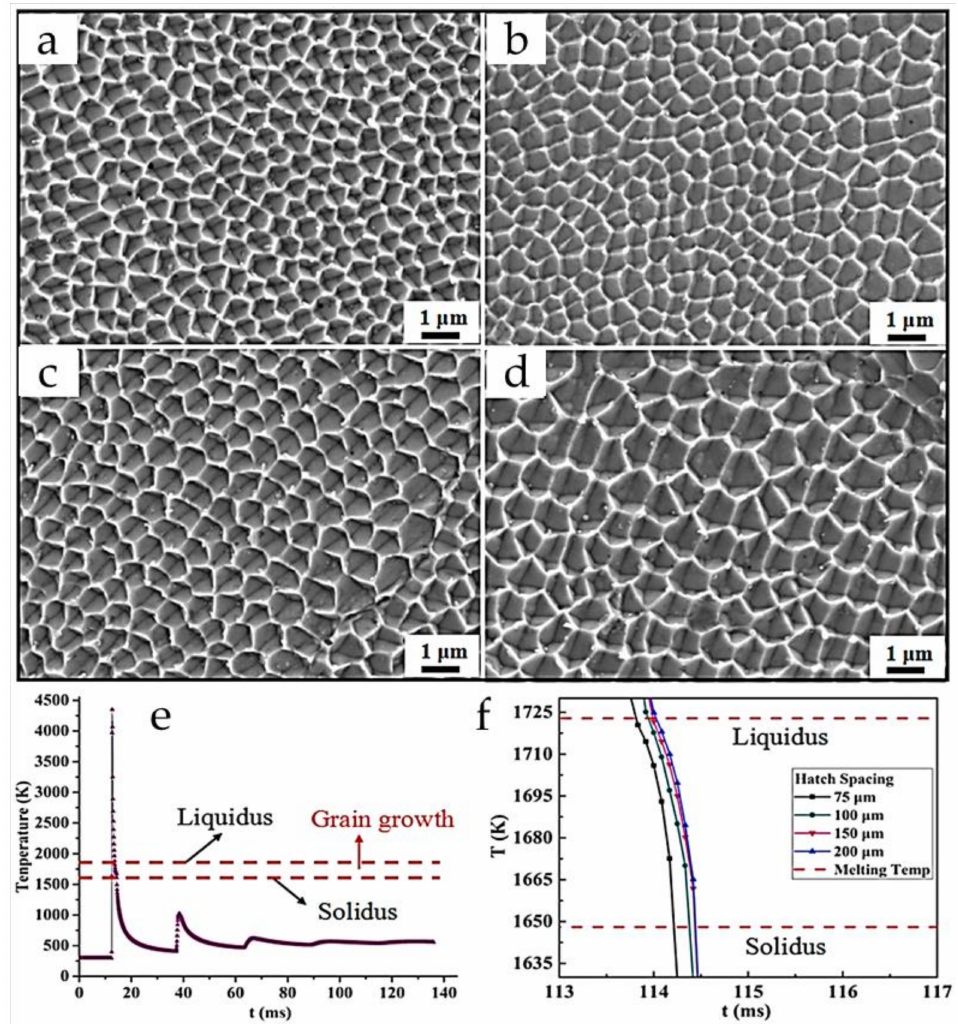
Figure 4. The microstructural formation of 316L SS under ( a ) 75 µ m, ( b ) 100 µ m, ( c ) 150 µ m, and ( d ) 200 µ m hatch spacings as well as ( e , f ) the relation of temperature and time of the laser melted particles to their liquidus and solidus states